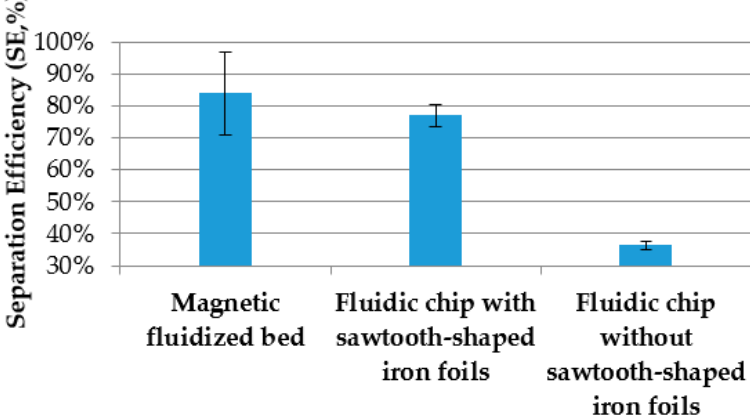
Figure 7. Separation efficiency of salmonella typhimurium at a concentration of 10 4 CFU/mL using a magnetic fluidized bed and fluidic chip with and without the sawtooth-shaped iron foils ( N = 3).